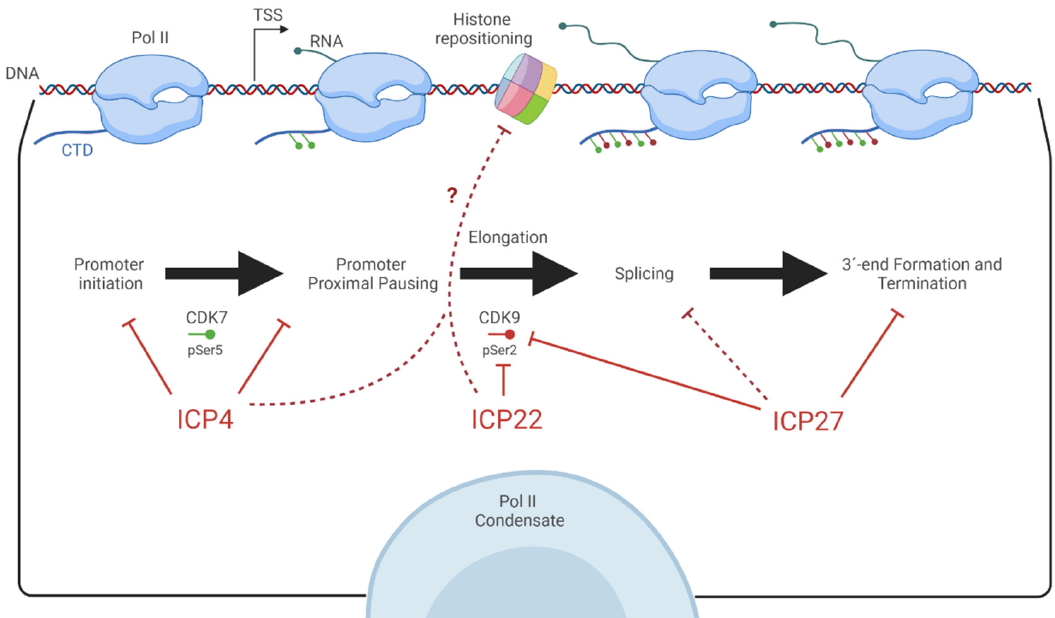
Figure 1. Graphical representation of the described transcriptional events herpes simplex virus antagonizes on host genes. Viral proteins are indicated in red with their reported inhibitory activities discussed in this review marked. The dashed arrows indicate possible links to observed defects in histone repositioning, or reconsiderations of splicing defects based upon new findings.